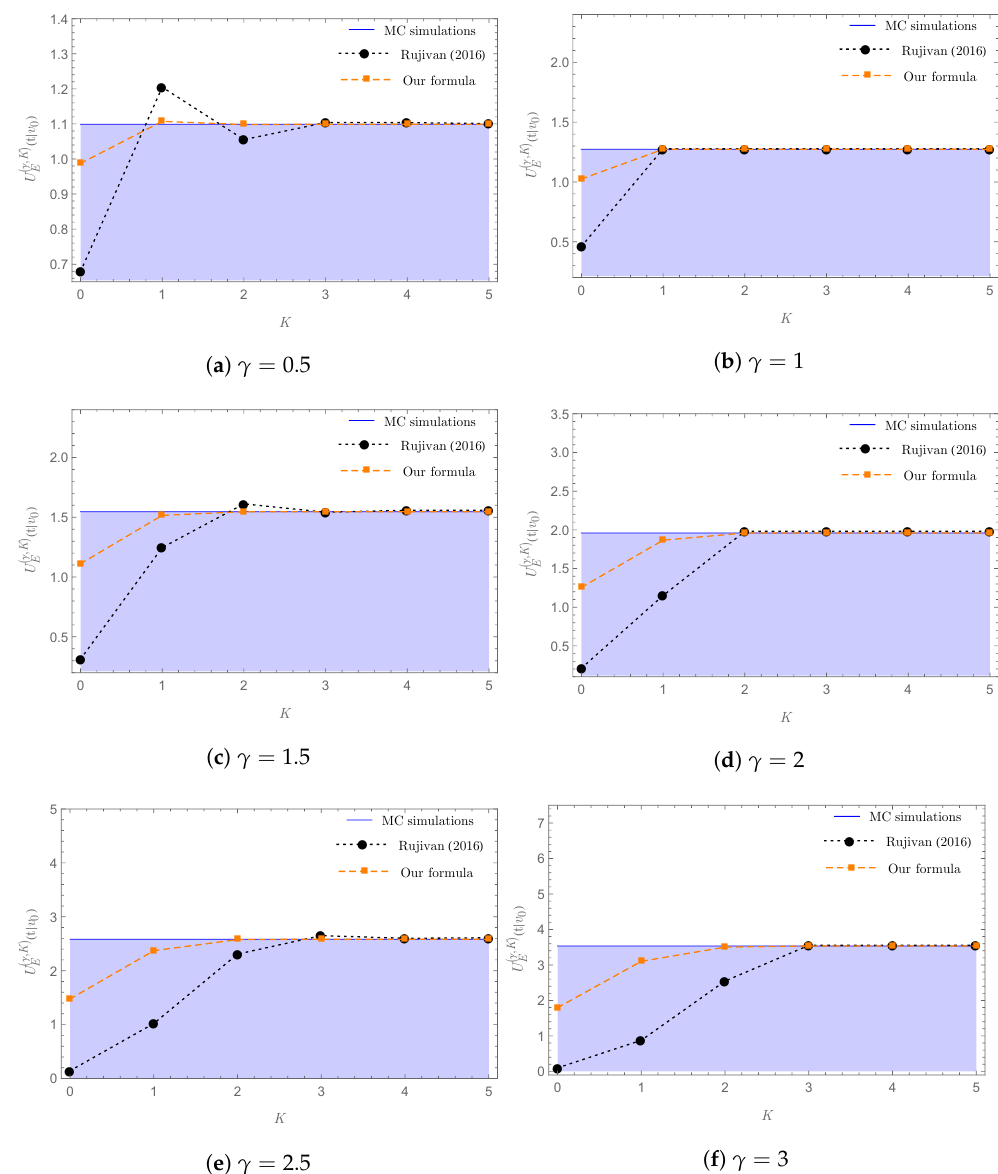
( γ , K ) ( t | v ) for K = 0, . . . ,5, computed from our explicit Formula (38) Figure 11. The sequences of U 0 E and the explicit formula written in Equation (2.2) of Rujivan [12], against the approximate value of ( γ ) ( t | v ) obtained from MC simulations based on the ECIR process (19) in Example 4 by setting U 0 E v 0 = 1 and t =